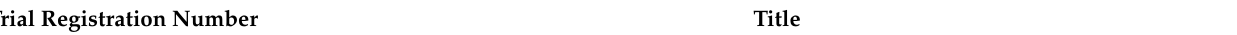
Table 3. Recruiting clinical trials with genetically engineered CAR T cells (https://clinicaltrials.gov) * in adult patients (>18 years of age) with